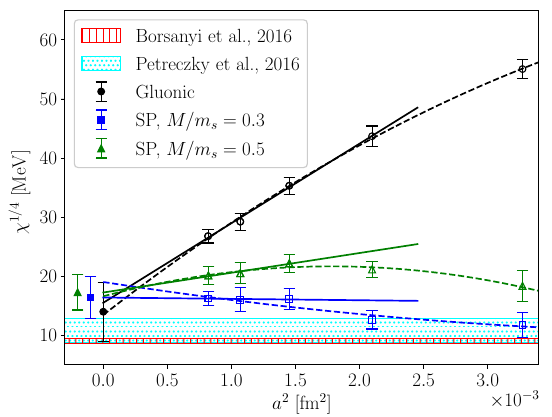
Figure 2. Comparison of the continuum extrapolations of χ 1 / 4 at T (cid:10) 430 MeV obtained with the gluonic and the SP discretizations. Data from Refs. [3, 4] are also reported for comparison. Data from [3] has been modified to remove the isospin-breaking term, while data from [4] has been mass- extrapolated to physical point using χ 1 / 4 ∼ m π